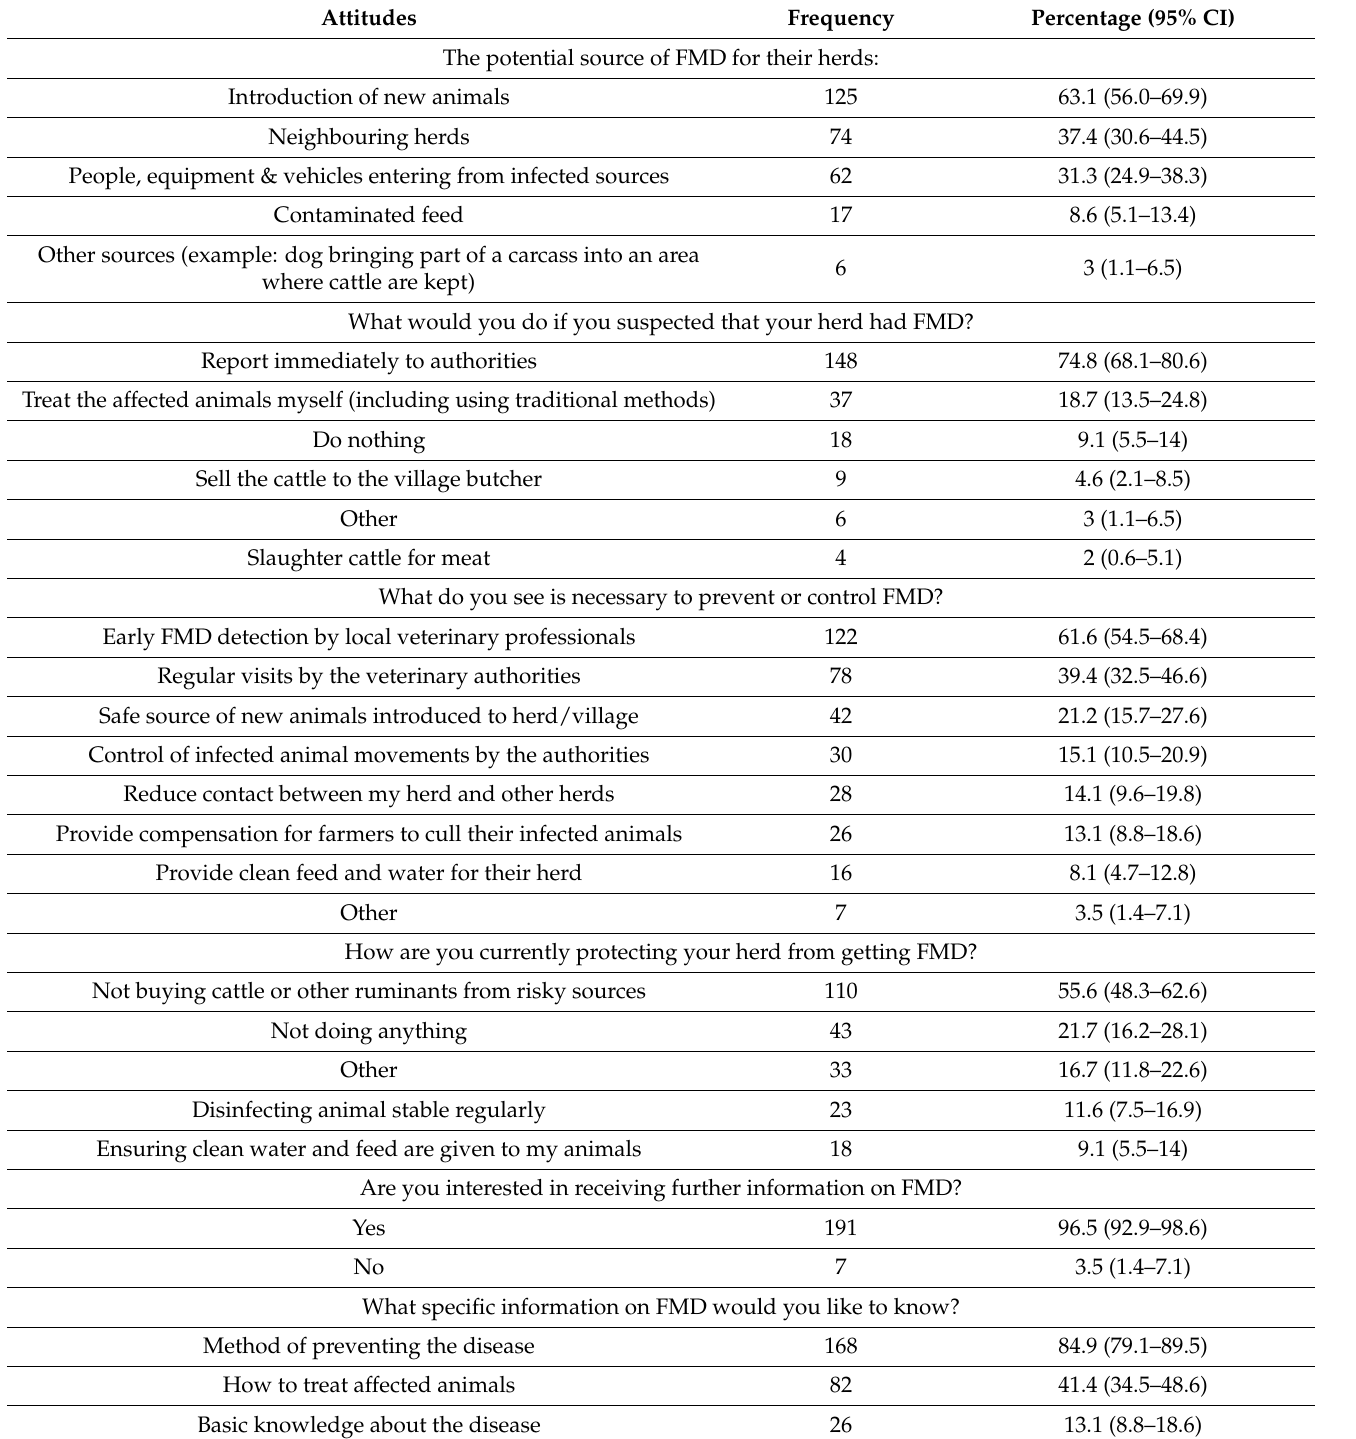
Table 2. Farmers’ ( n = 198) attitudes and practices towards control of foot and mouth disease (FMD) in their herds.